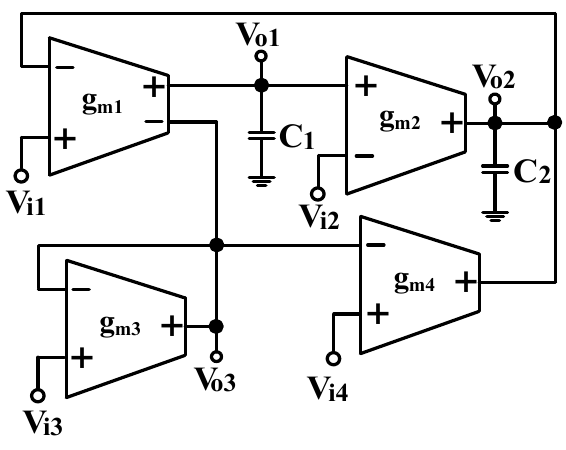
Figure 2. Symbols for operational transconductance amplifier (OTA) and dual-output operational transconductance amplifier (DO-OTA). ( a ) OTA. ( b ) DO-OTA.